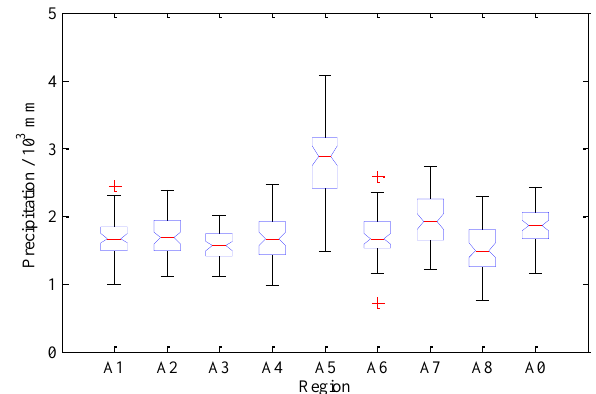
Figure 3. Box plot of precipitation of sub-regions and the entire region. The upper and lower boundaries of the box were set to the values of their percentiles as one-quarter and three-quarters, Q 1 and Q 3 , respectively. The red solid line refers to the median. The upper and lower boundaries extended along the dashed line were further set to the values as Q 1 + 15 (Q 1 − Q 3 ) and Q 3 − 15 (Q 1 − Q 3 ) , re- spectively. The values beyond extended boundaries were generally regarded as abnormal, marked by the red plus